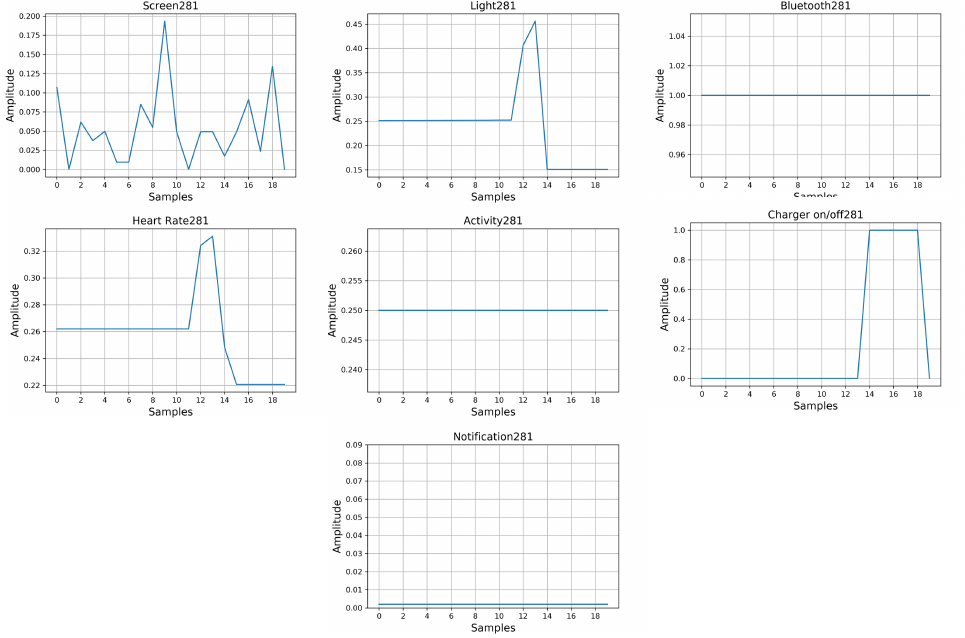
Figure A1. Sample 281 (Screen, light, Bluetooth, heart rate, activity, notification, and charger on/off